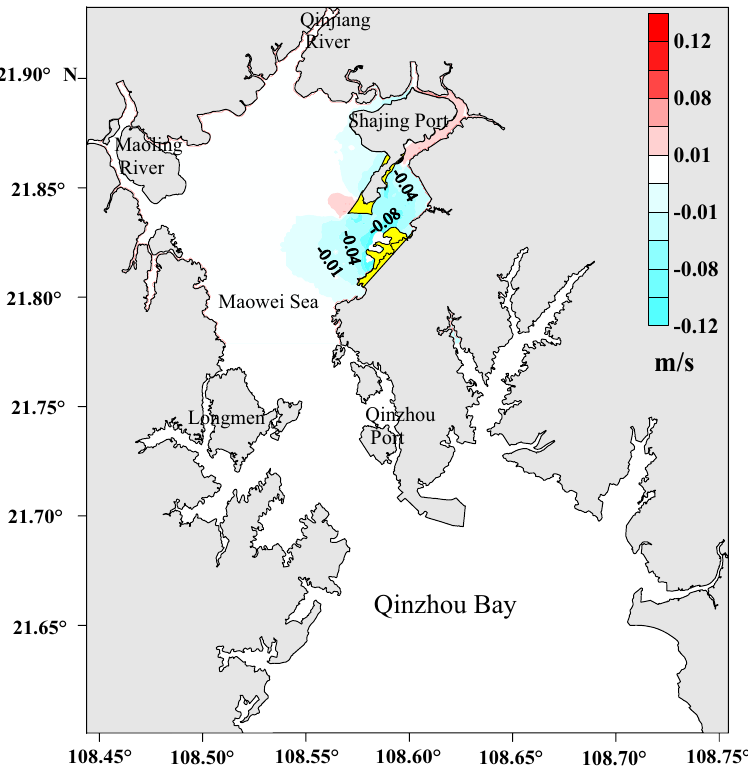
Figure 4. The variations of average velocity in Maowei Sea after the project (a positive value indicates an increase while a negative value means a decrease). The figure was drawn with Surfer10 Software (https:// www. golde nsoft ware. com/ produ cts/